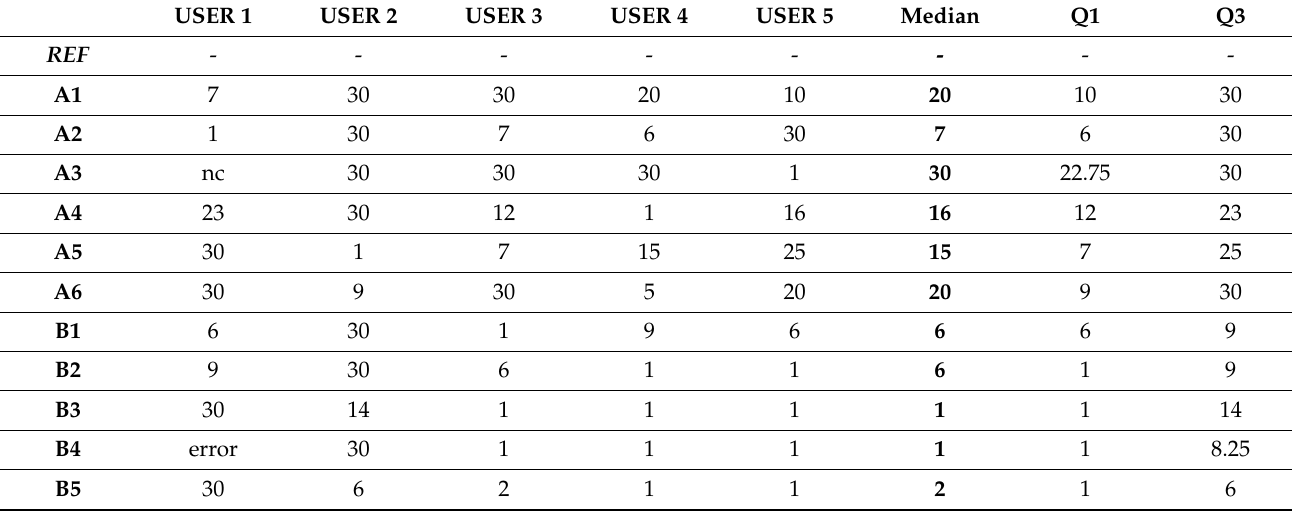
Table A4. Users’ number of steps to reach the cadence of 100